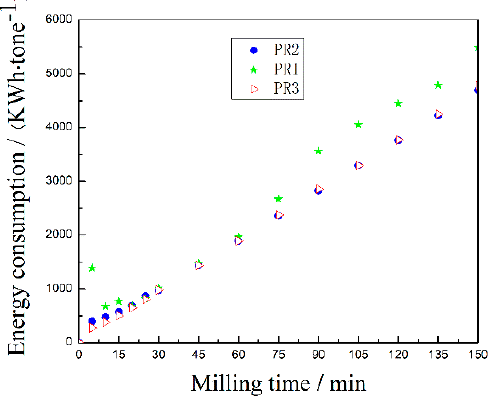
Figure 8. Energy consumption of three PR powders at different milling times.